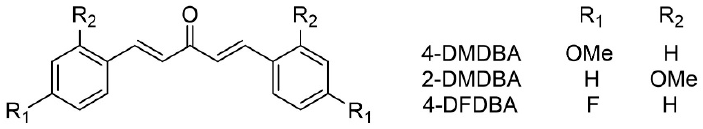
Figure 1. The molecular structure of the dibenzylideneacetone derivatives.